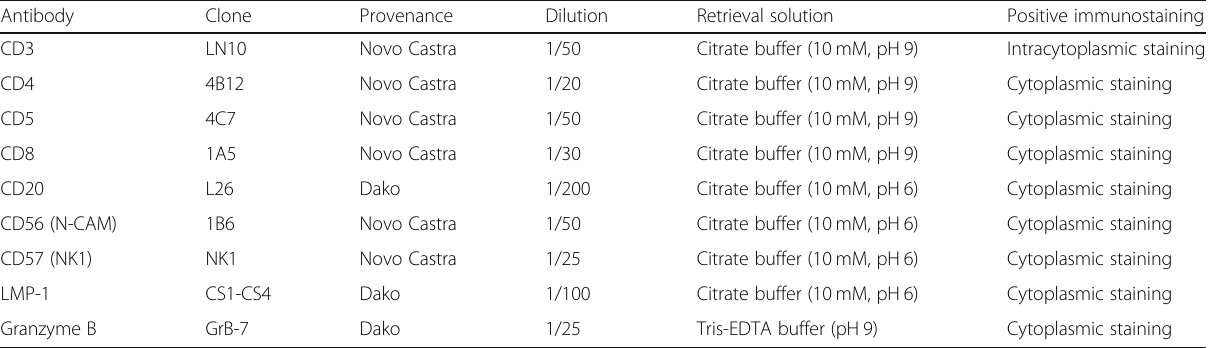
Table 1 Immunohistochemistry conditions and evaluation Antibody Clone